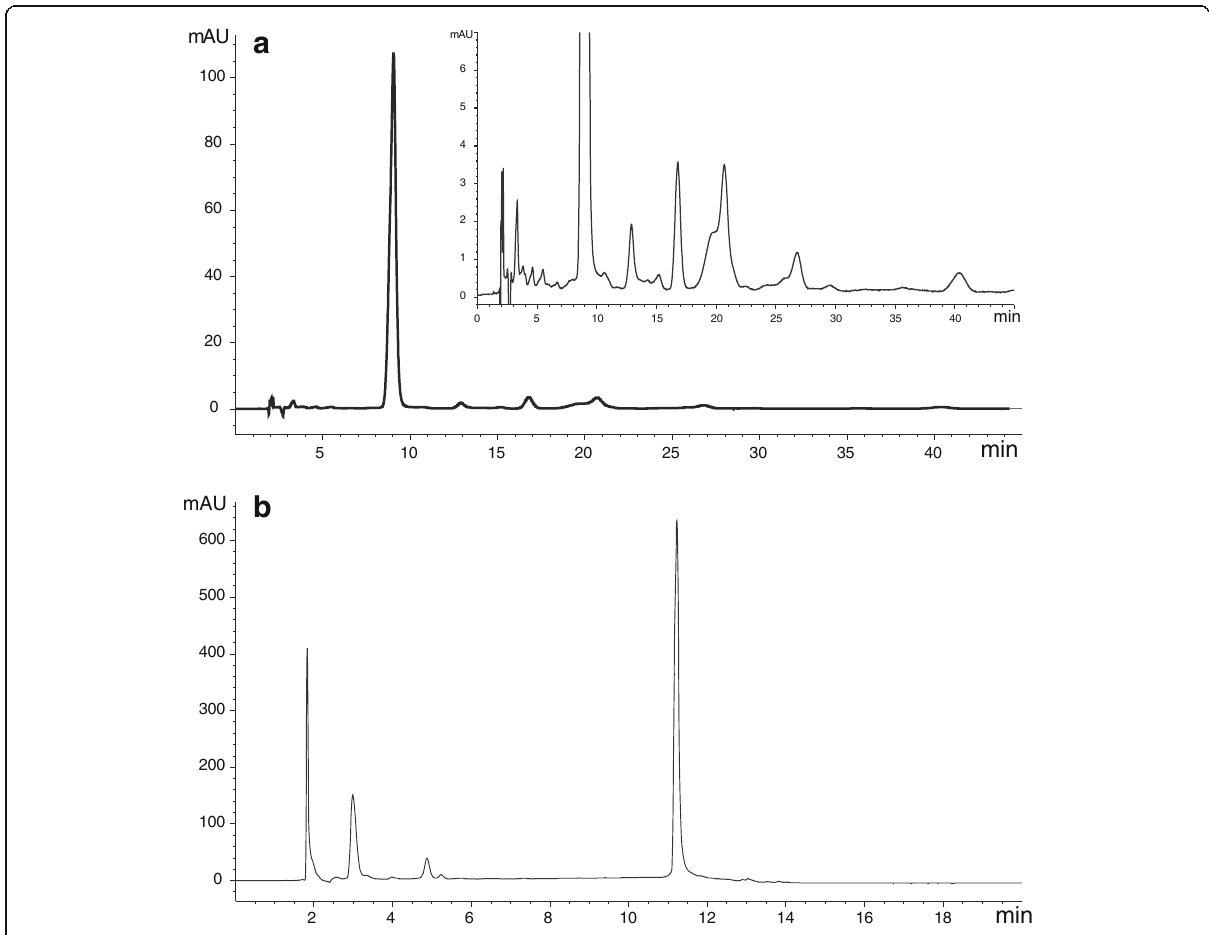
Fig. 9 HPLC traces of ( a ) EtOAc extract (insert shows the same HPLC trace with the expansion of Y axis) (isocratic elution with 90:10 MeCN − 1.0% HOAc in H 2 O at a rate of 1 mL/min at 30 °C) and ( b ) MeOH extract of F. racemosa (stepwise gradient elution with MeCN − 1.0% HOAc in H 2 O as follows; 0.00 – 4.00 min with 10:90, 4.00 – 8.00 min with 15:85, 8.00 – 10.00 min with 20:80 and 10.00 – 20.00 with 100%